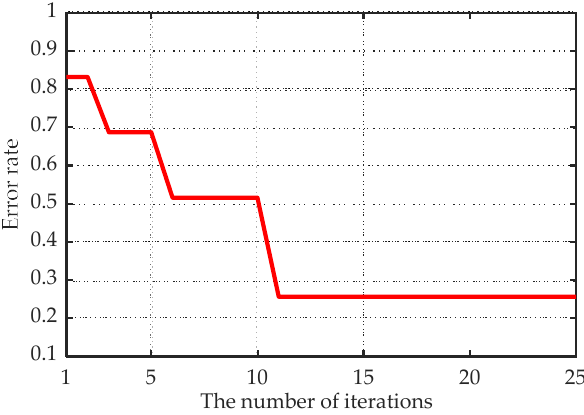
Figure 6. The optimization process of the PSO algorithm.